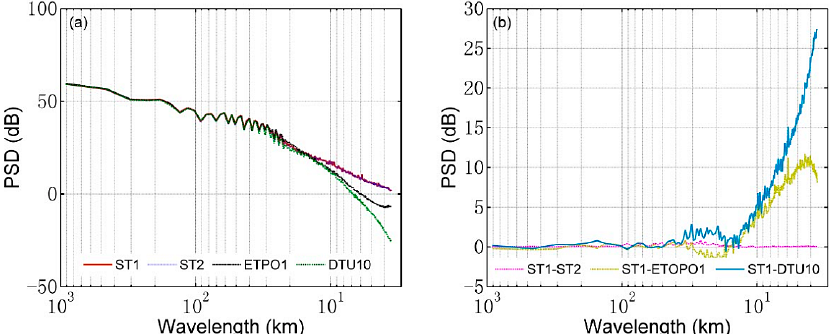
Figure 11. Analytical results of the topographic power spectra density: ( a ) variation curve of the power spectral density and ( b ) curve of the difference in power spectral density.